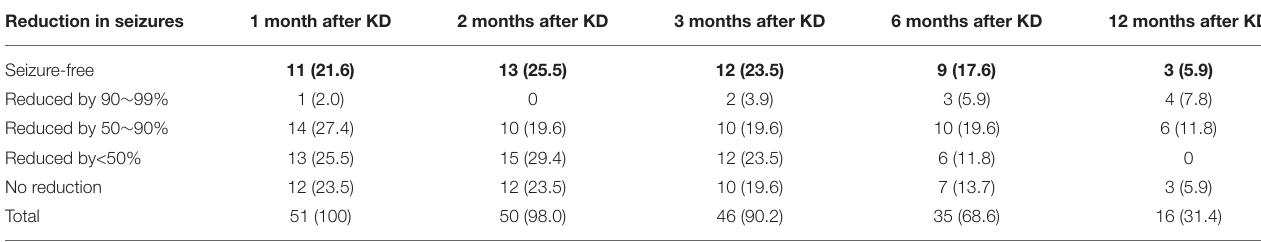
TABLE 2 | Response rate in seizure reduction at 1, 2, 3, 6, and 12 months after KD ( n , %).